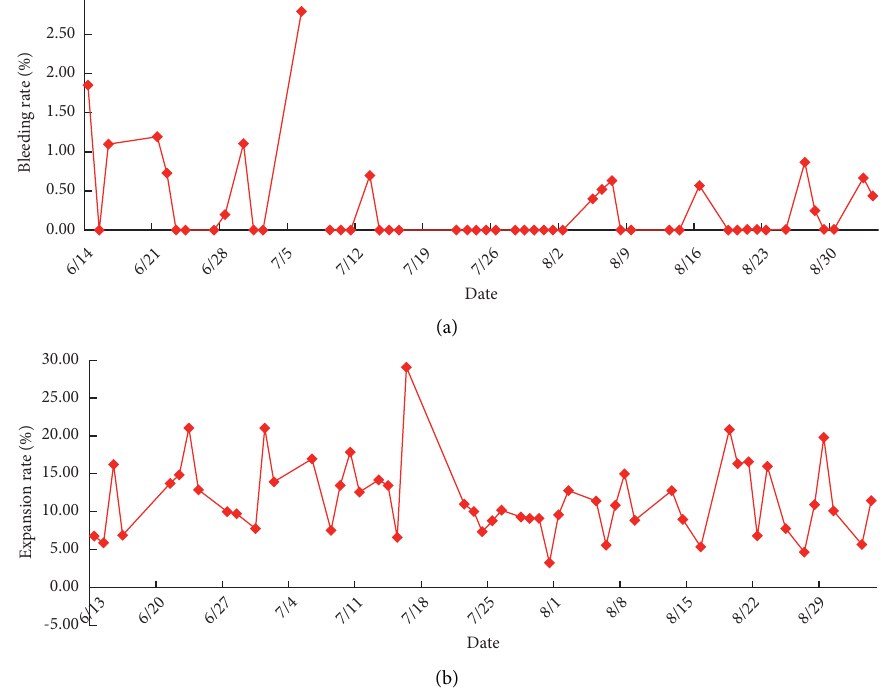
Figure 5: Improved filling material test curve of (a) bleeding rate and (b) expansion rate.